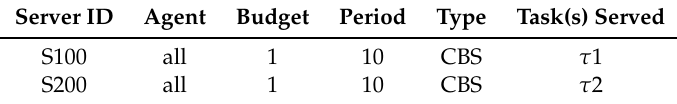
Table 3. Common server characterization.